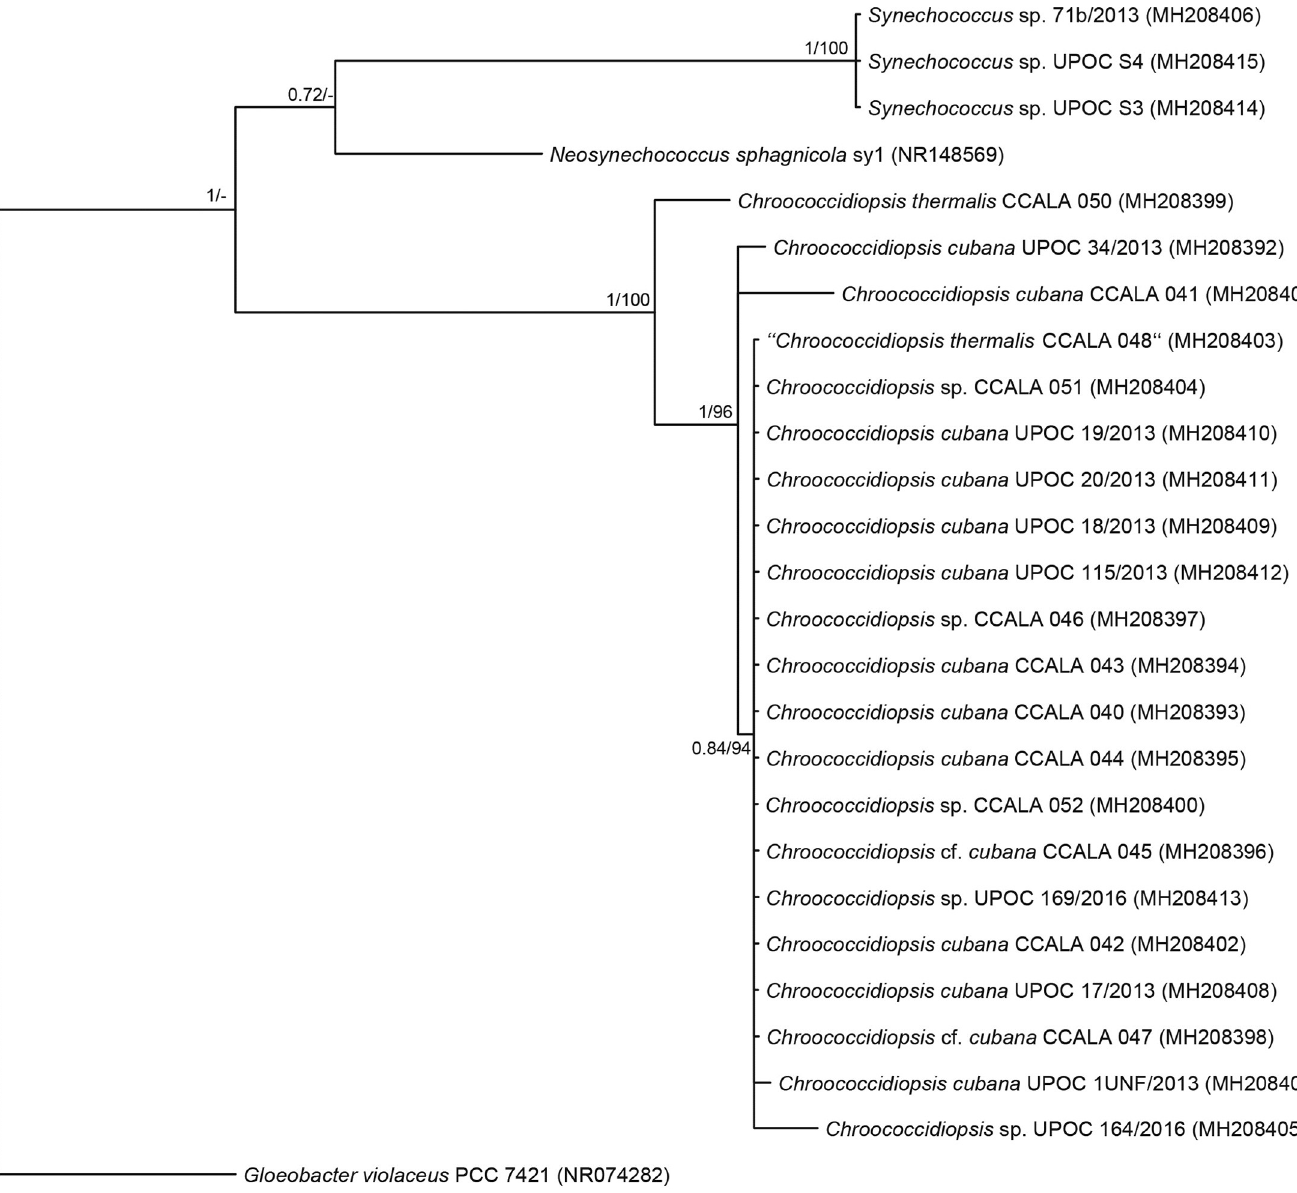
Fig 7. A phylogenetic tree based on sequencing of 16S rRNA gene. This consensus Bayesian tree includes sequences from 21 strains of the genus Chroococcidiopsis , 4 strains of Synechococcus sensu lato and Gloeobacter violaceus PCC 7421 as outgroup. Node supports are shown in the following order: Bayesian posterior probabilities and maximum likelihood. GenBank accession numbers of the respective 16S rRNA sequences are provided in